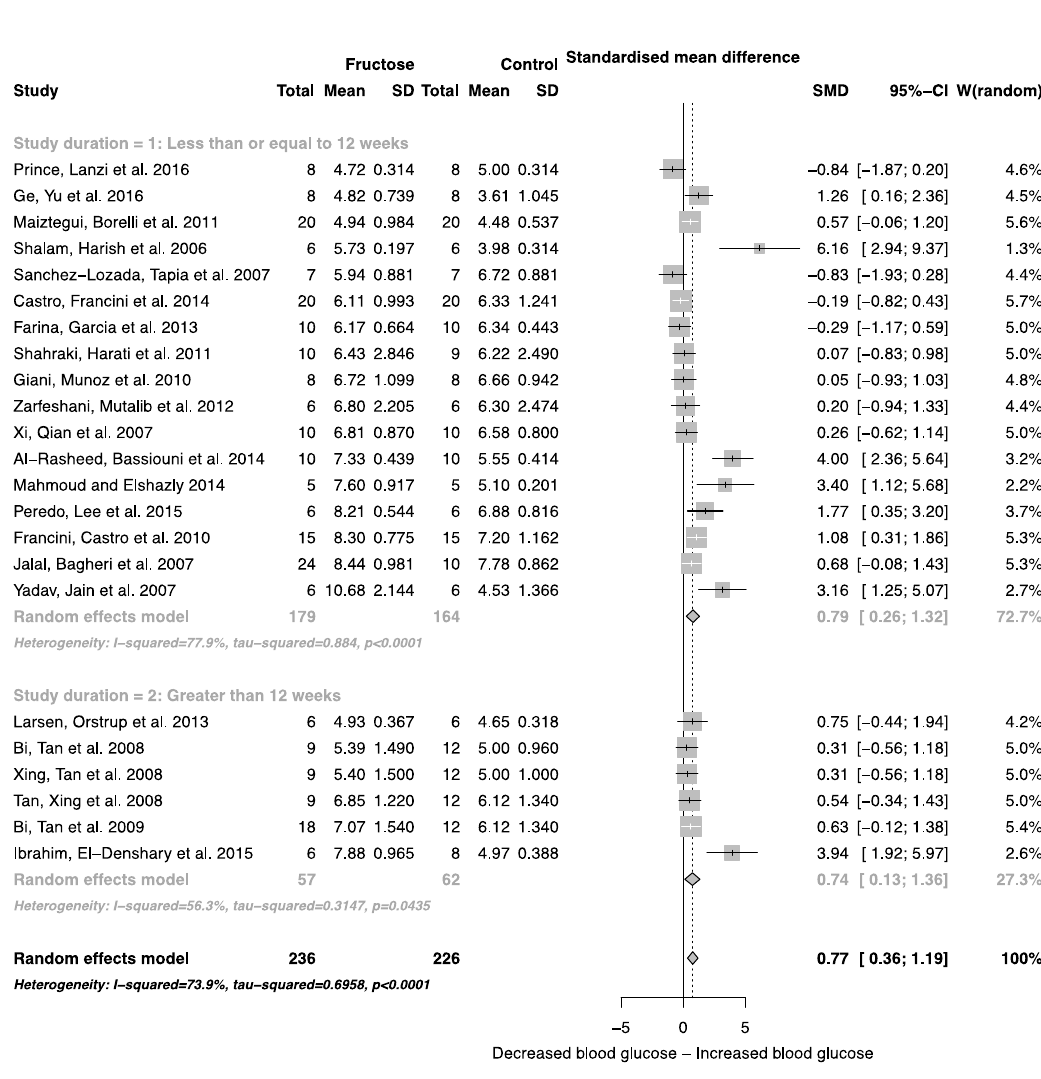
Figure 4. Forest plots of the effect of fructose consumption on adult male rodent blood glucose concentration (mean and standard deviation (SD)), split by study duration. The pooled effects estimates are represented by three diamonds; one for studies of 12 weeks or less, one for studies of greater than 12 weeks, and one representing the combined effect. Data are presented as standardized mean differences (SMD) with 95% confidence interval (CI). p ‐ Values are for the inverse variance random effects models with DerSimonian ‐ Laird estimator for Tau 2 . Inter ‐ study heterogeneity was tested by Cochran’s Q at a significance of p < 0.10 and quantified by I 2 .